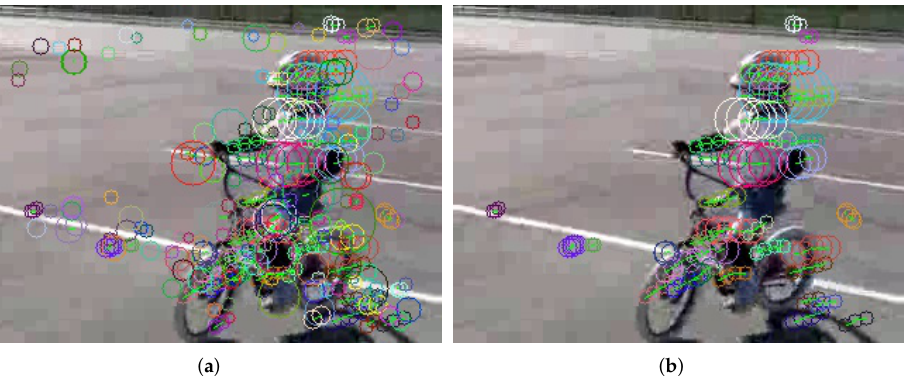
Figure 15. Illustration of SURF points filtered by only trajectories filtering. (The frame is the NO. 70 frame from the video ”v_biking_01_01.avi” in the Hollywood2 dataset.) ( a ) Trajectory length from 1 to 5. ( b ) Trajectory length from 3 to